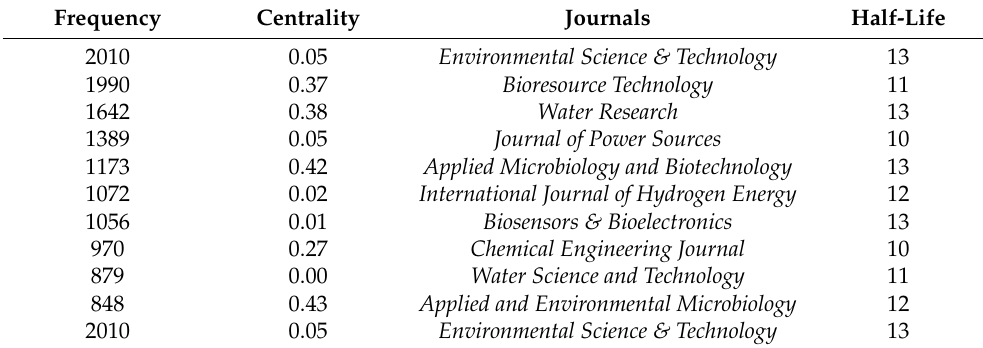
Figure 6. Main journals cluster on MFCs in wastewater treatment. Table 7. The top 10 journals according to frequency on MFCs in wastewater treatment.